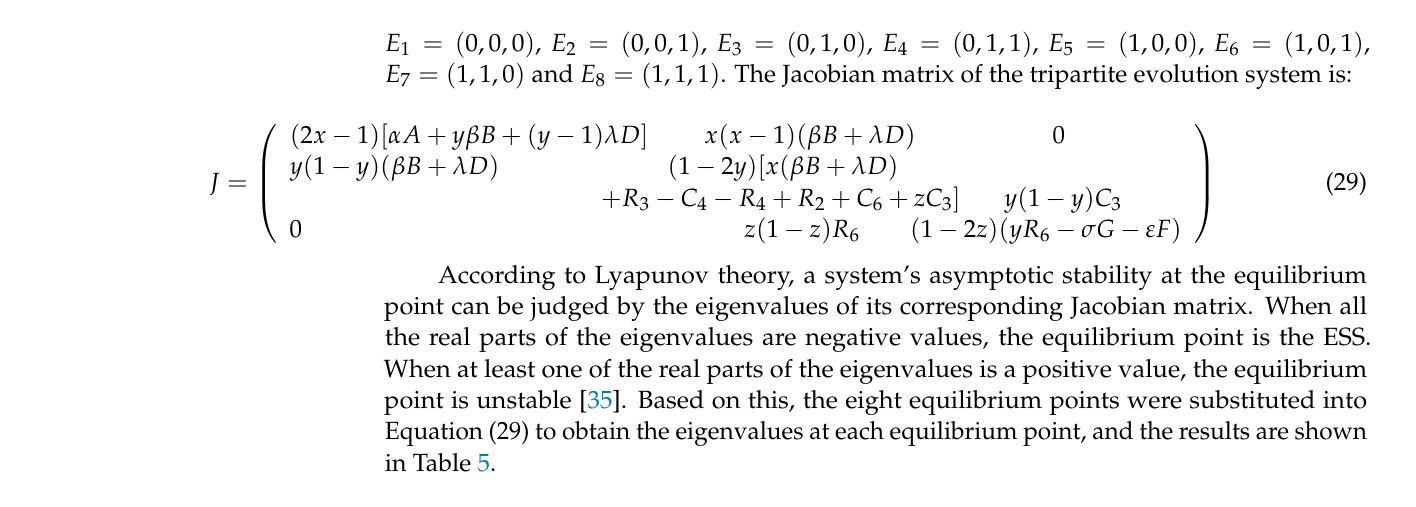
Table 5. Stability analysis of equilibrium